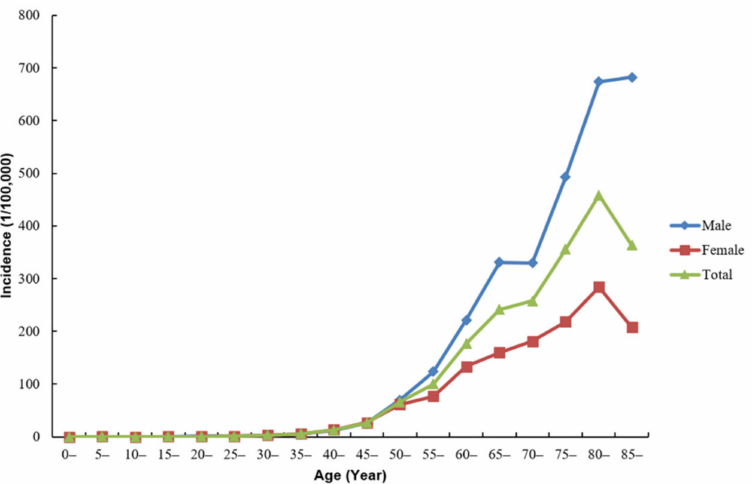
Figure 1. The age-specific incidence of new lung cancer cases in Shenzhen,